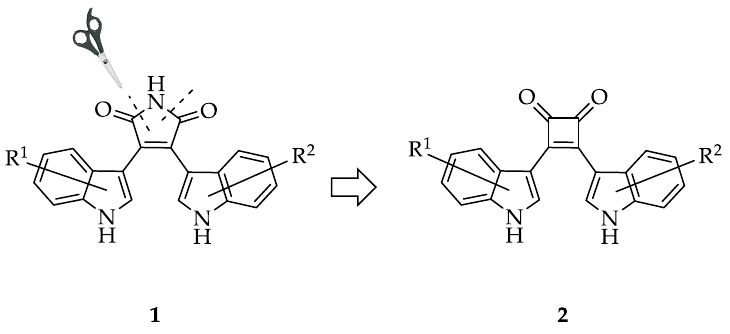
Figure 1. Design of 3,4-bis(indol-3-yl)cyclobut-3-ene-1,2-diones 2 by formally cutting out the imide nitrogen of bisindolylmaleimides (BIMs, 1 ). R 1 and R 2 indicate substituents attached to positions 1, 2, 4, 5, 6, or 7 of the indole ring system.